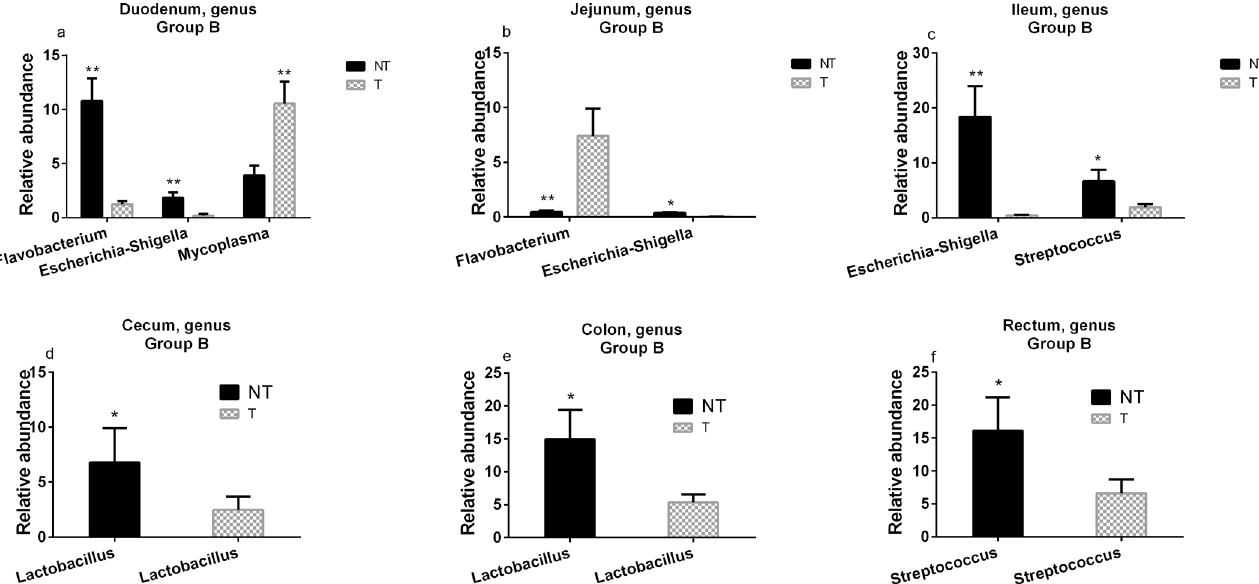
Fig 6. Comparative analysis of genera in various intestinal sections collected from transgenic and non-transgenic pigs in Group B. Significant differences between transgenic (T) and non-transgenic (NT) pigs were observed in changes in the relative abundance at the genus level in fecal samples from the duodenum (a), jejunum (b), ileum (c), cecum (d), colon (e), and rectum (f). * P < 0.05; ** P <